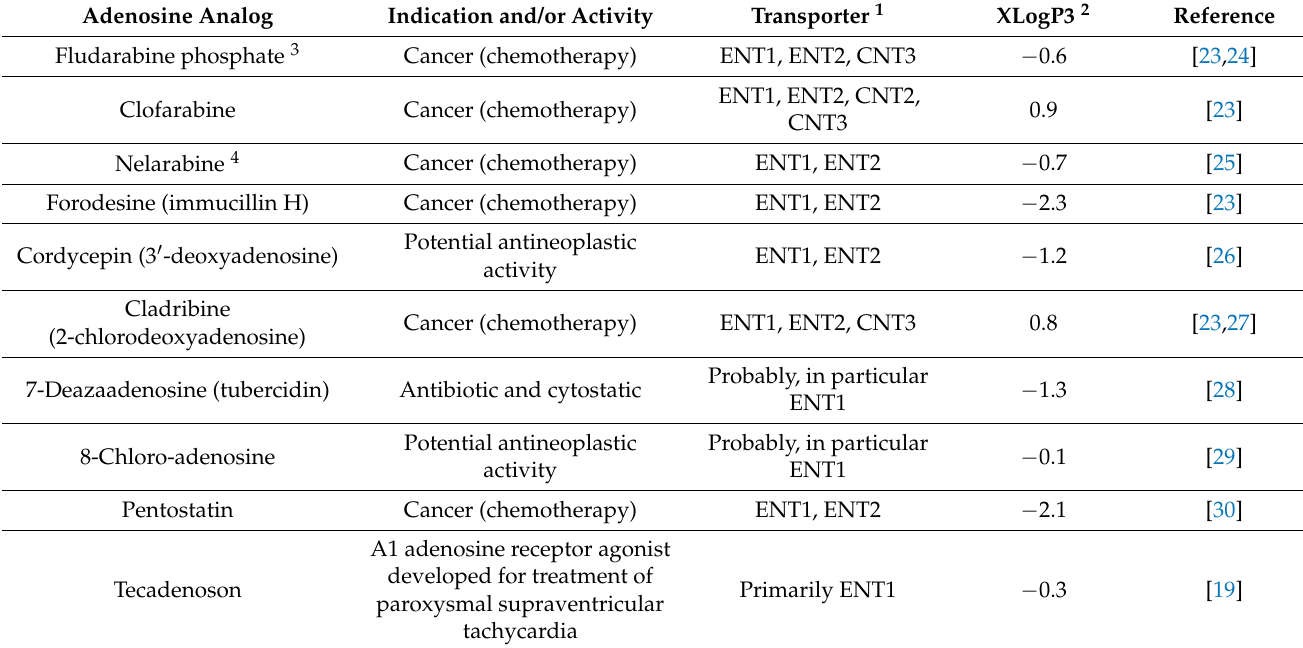
Table 1. Pentose group-containing purine nucleoside analogs and their transporters.